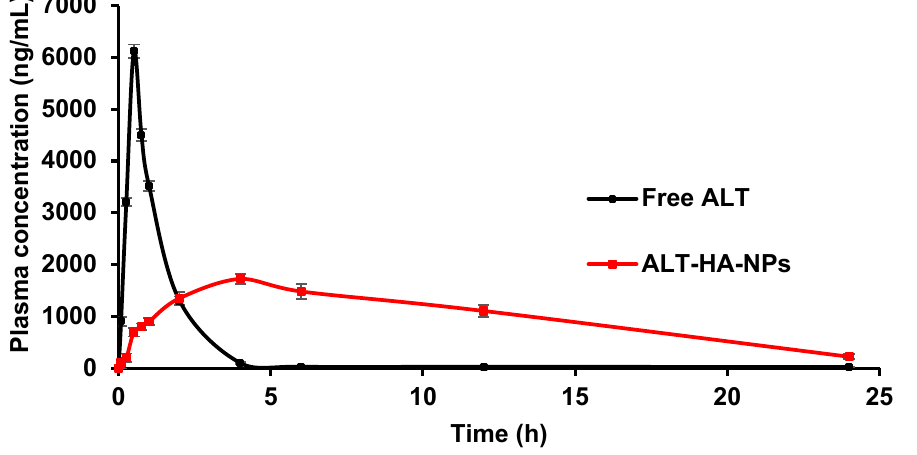
Figure 5. Plasma concentration–time curve after the intravenous injection of free ALT and ALT-HA- NPs in male Wistar rats ( p < 0.001, mean ± SD, n = 3).